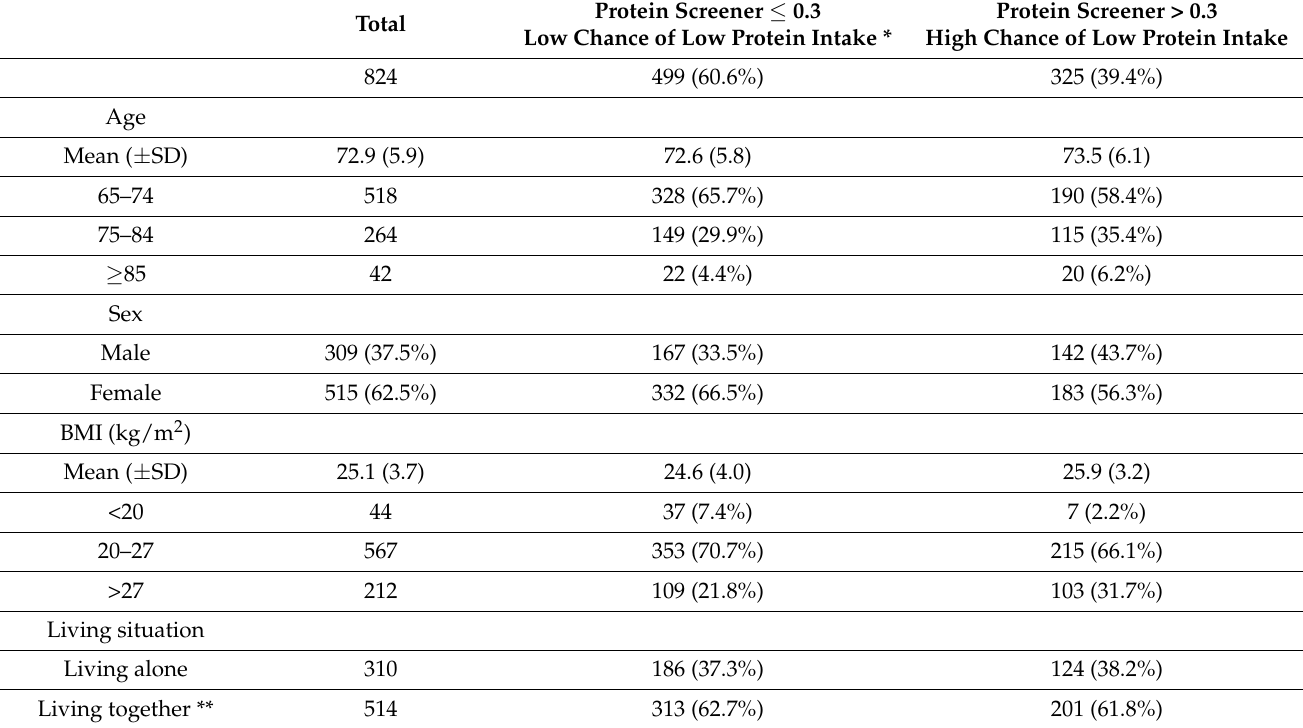
Table 2. Sociodemographic characteristics of all respondents and for respondents with a high and low chance of a low protein